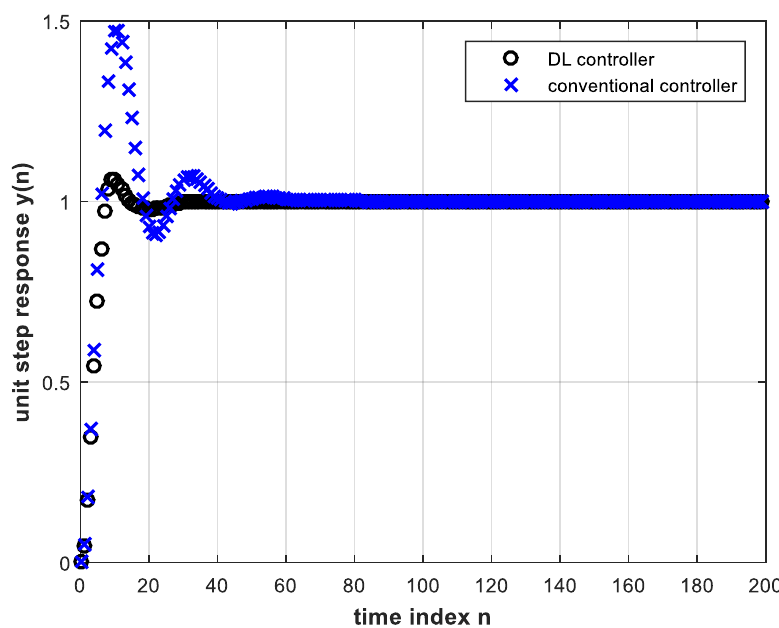
Figure 10. Unit step response of the feedback control system with the trained DL controller (four hidden layers and four input nodes) as well as with the conventional controller, both under plant gain change, Equation (14).